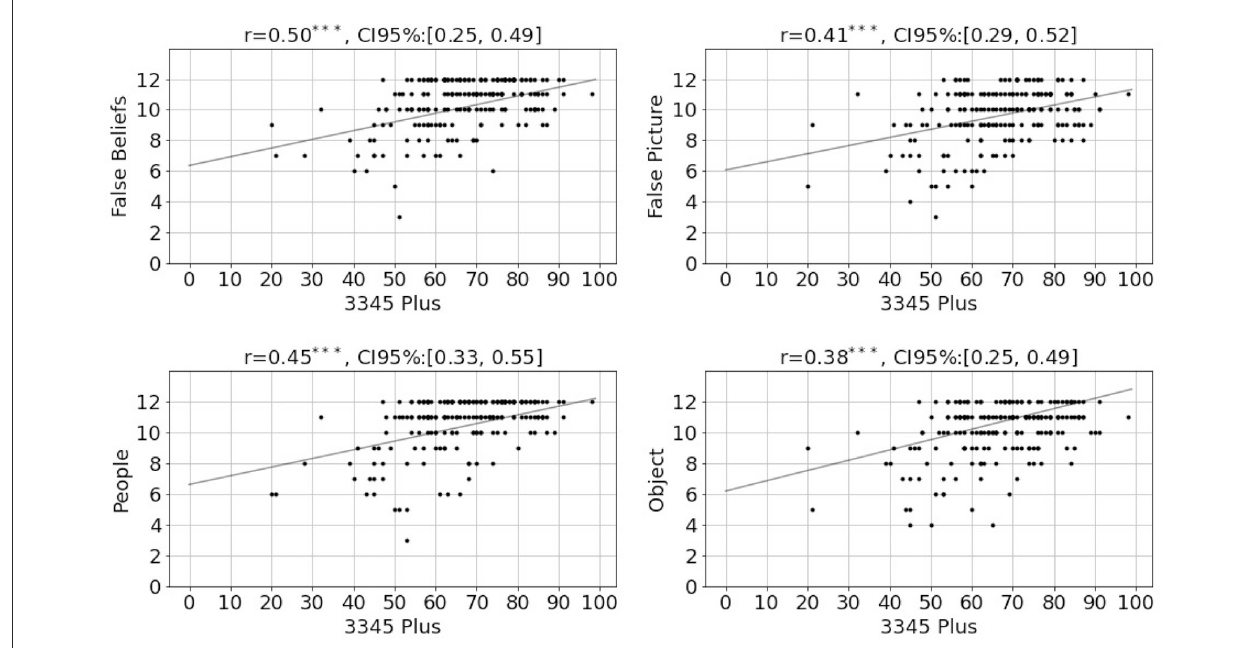
FIGURE4 Relationship between the computer’s 3345plus results and the different subcategories of the Mental State Stories. False beliefs, Inferences about people (Theory of Mind); False Picture, Inferences about objects; People, Facts about people; Object, Facts about objects. ∗ P ≤ 0.05, ∗∗ P ≤ 0.01, ∗∗∗ P ≤ 0.001.